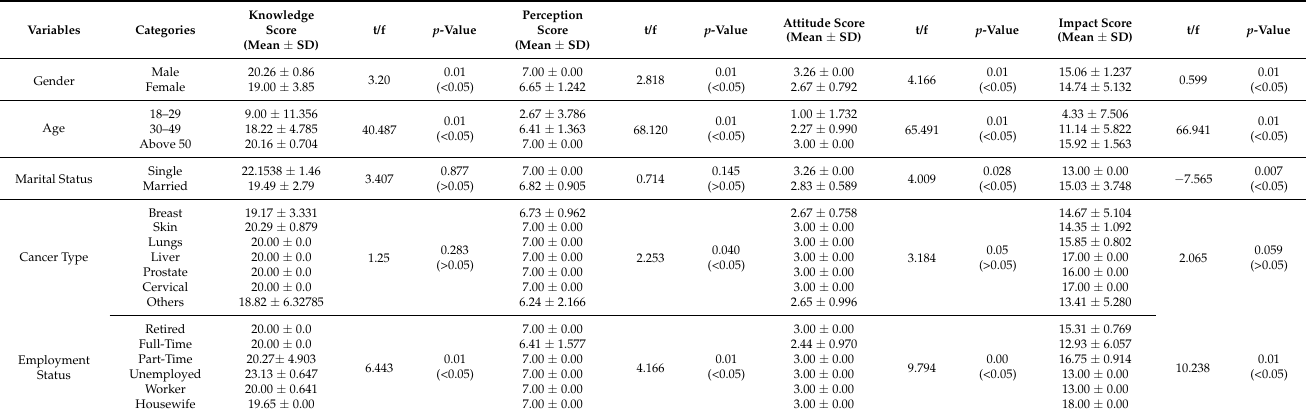
Table 3. Association of knowledge, perception, attitude, and impact of COVID-19 with demographic variables of cancer patients (N = 208).